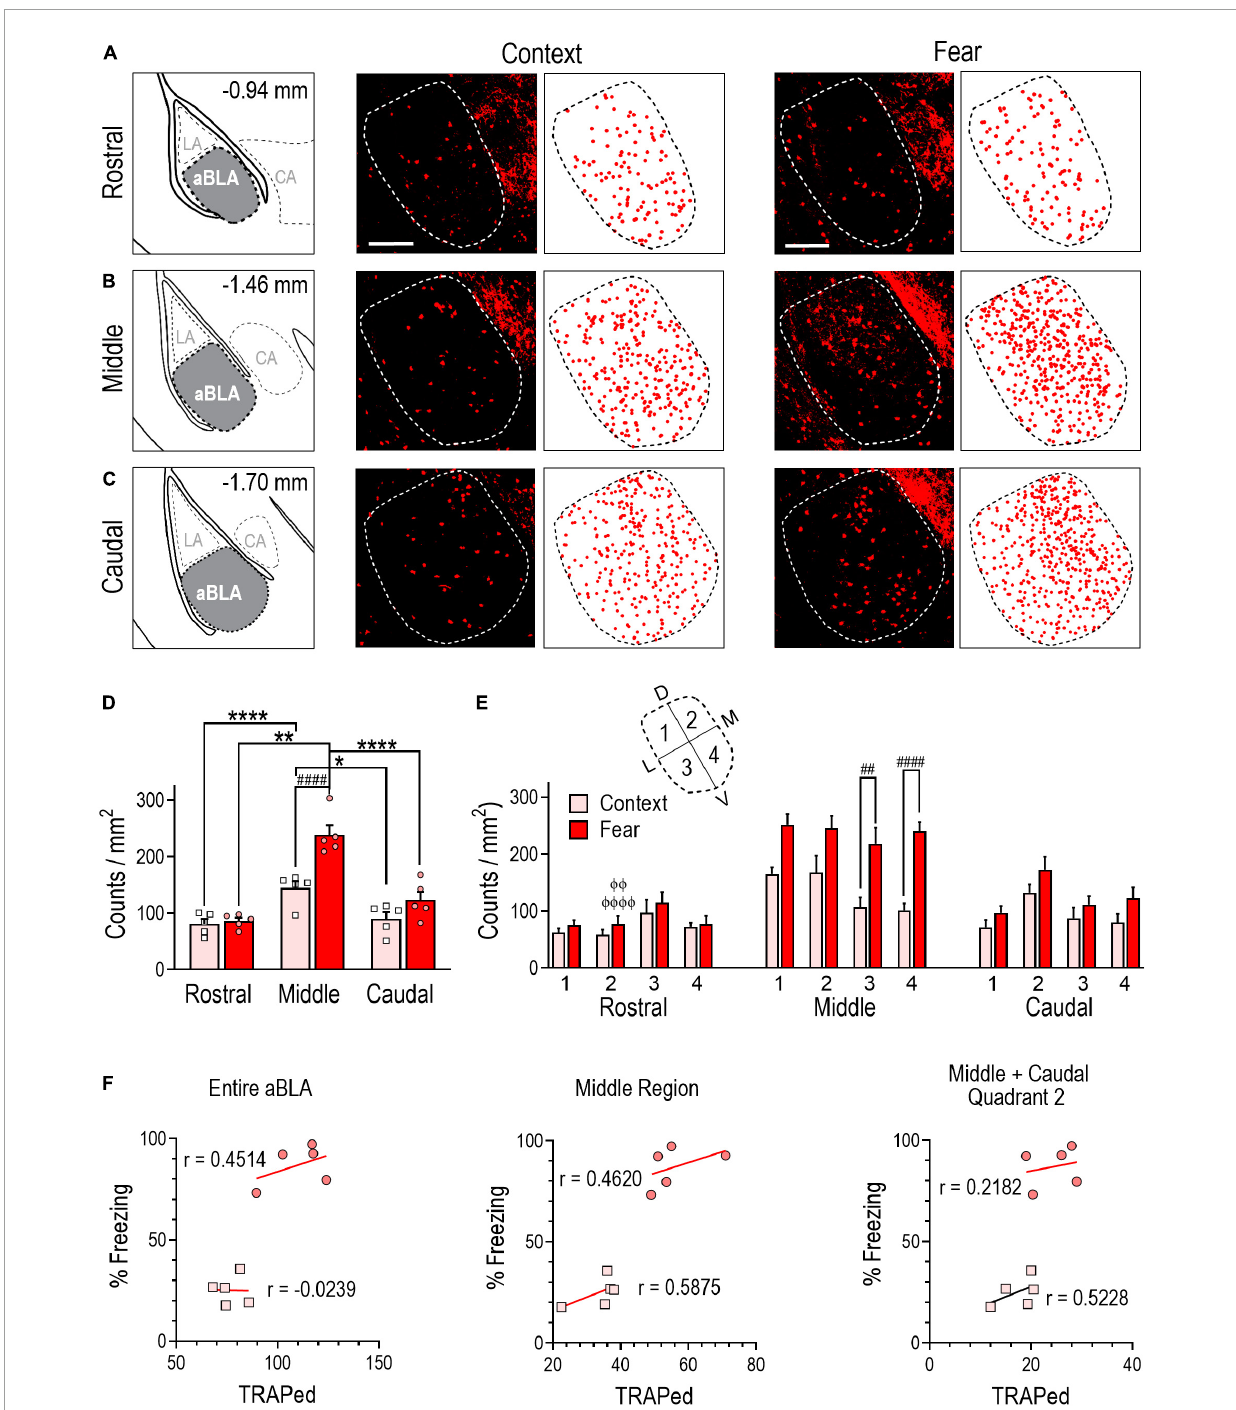
FIGURE2 Contextual fear memory formation induces an enlarged neuronal ensemble in the aBLA. (A–C) Stereotaxic plate drawings of aBLA sub-regions (left), representative images of context-TRAPed tdTomato + (red) neurons and their summary distribution plot (center, n = 5 mice), and representative fear-TRAPed tdTomato + (red) neurons and their summary distribution plot (right, n = 5 mice). (A) Rostral sub-region. (B) Middle sub-region. (C) Caudal subregion. Scale bar (top, left) = 200 µ m. (D) Average density of TRAPed neurons in each analyzed aBLA sub-region in context ( n = 5) and fear ( n = 5) groups. * P = 0.0132, **** P < 0.0001 between sub-regions in the context group. ** P = 0.0035, **** P < 0.0001 between sub-regions in the fear group. #### P < 0.0001 between groups. Two-way ANOVA with Sidak’s post-test. (E) Distribution of TRAPed neurons in quadrants (inset) of the rostral, middle, and caudal aBLA in context and fear groups. ## P = 0.0031, #### P < 0.0001 between groups. φφ P = 0.0040, φφφφ P < 0.0001 between sub-region and within-fear and within-quadrant. Three-way ANOVA with Tukey’s post-test. Data are mean ± SEM. (F) Correlations showing the relationship between the amount of time mice spent freezing during remote context memory (squares) or fear memory (circles) recall and tdTomato + counts (TRAPed) in the entire aBLA (left), its middle sub-region (center) and in quadrant 2 of the middle and caudal sub-regions (right). In each graph, lines represent the least squares regression for each correlation. Within each treatment group, Pearson’s coefficients (r) were not significant for any correlation. Between groups, Fisher’s z transformation was applied and coefficients (r’) were not different between groups for any correlation (see Supplementary Table 1